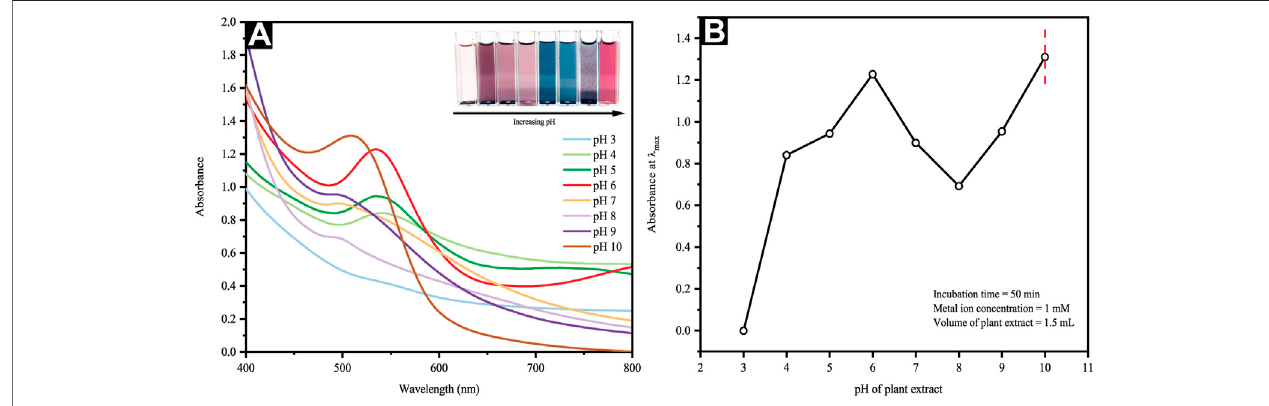
FIGURE 4 | (A) UV-Vis spectra and optical images of reaction mixtures at different pH and (B) a plot of maximum absorbance versus extract pH.